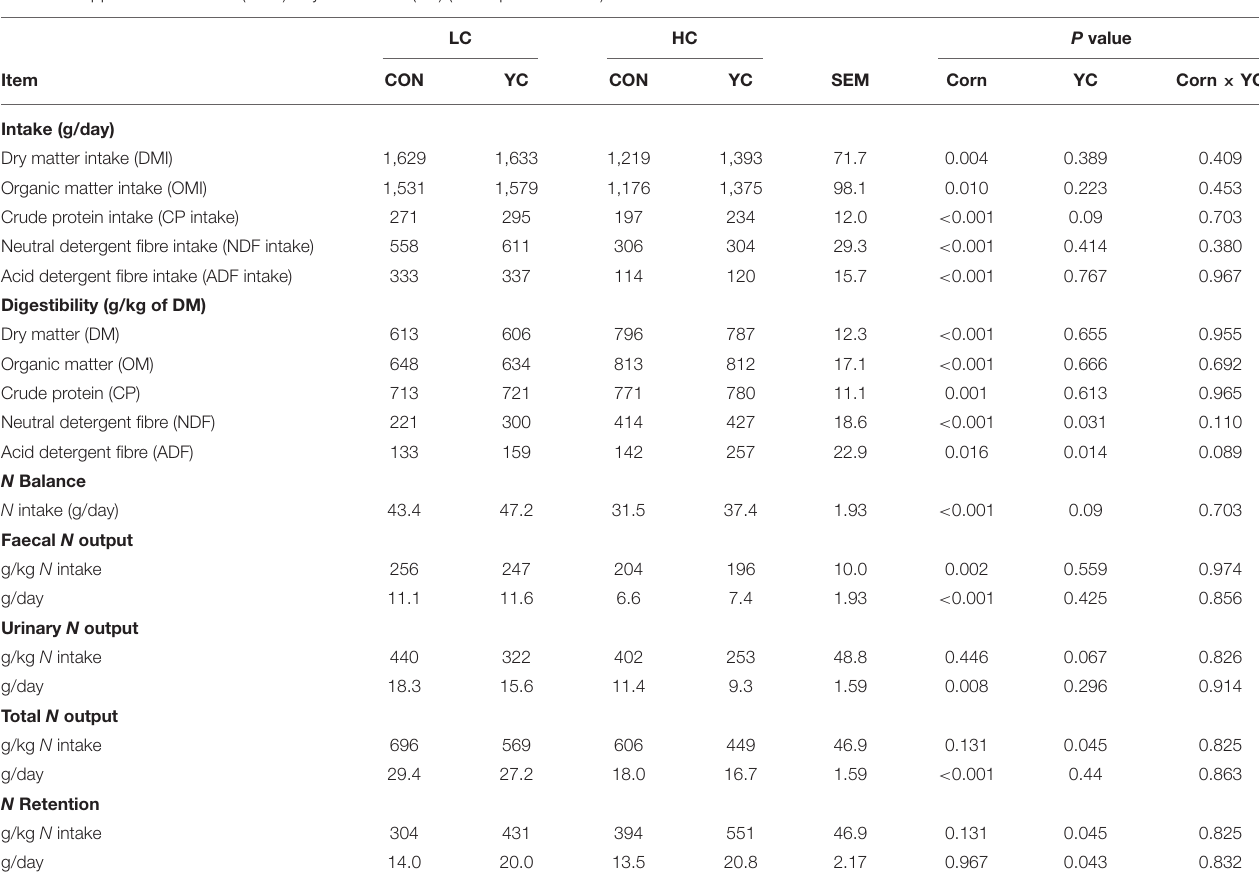
TABLE 3 | Intake, total tract apparent nutrient digestibility, and nitrogen balance of fattening lambs fed experimental diets containing a low (LC) or high (HC) proportion of corn and supplemented with nil (CON) or yeast culture (YC) ( n = 6 per